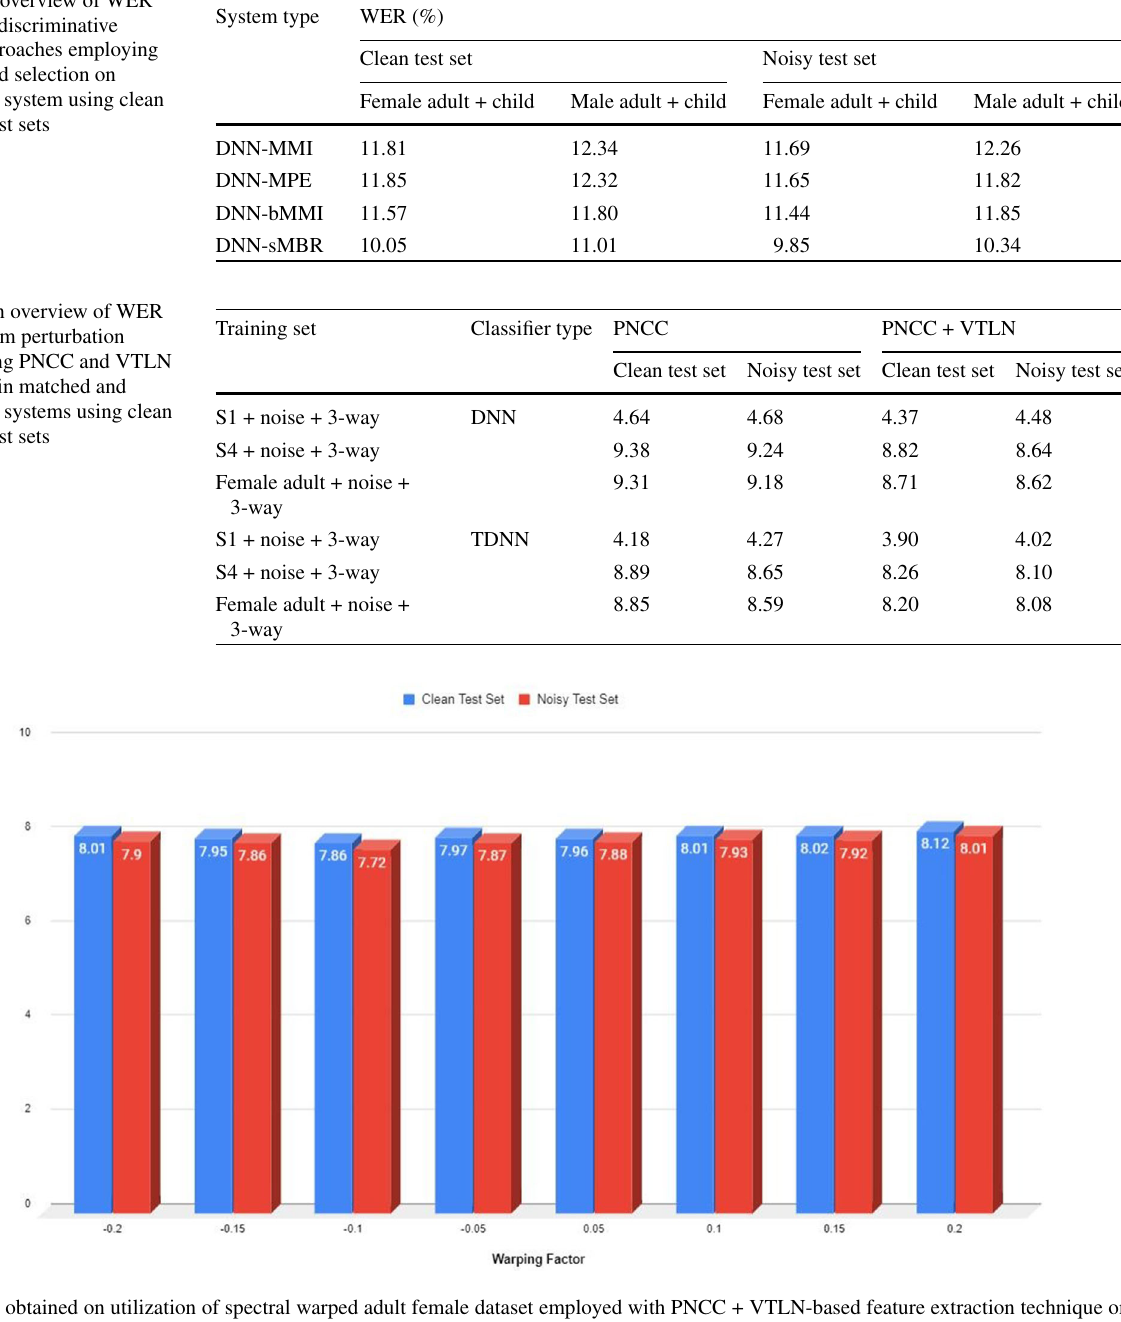
Fig. 8 WER obtained on utilization of spectral warped adult female dataset employed with PNCC + VTLN-based feature extraction technique on mismatched